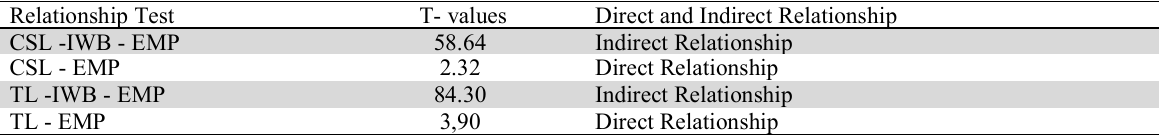
Direct and indirect